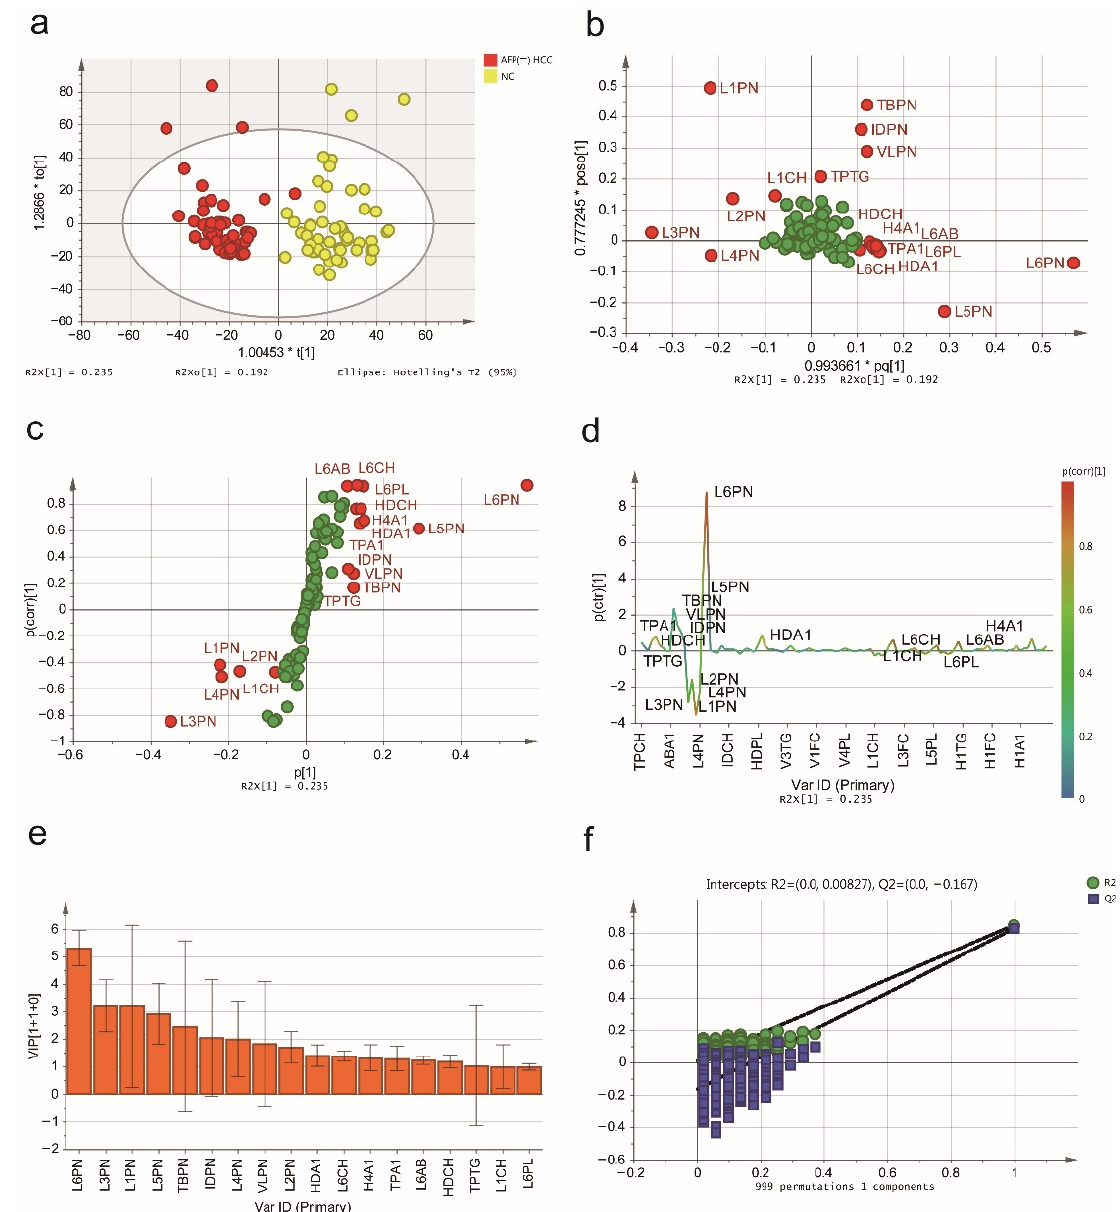
Figure 3. The serum lipidomic profile discriminates between AFP-negative HCC patients and NCs. ( a ) Score plot was generated by the OPLS-DA model. The horizontal coordinate (1.00453 * t [1]) represents the score value of the main component, and the vertical coordinate (1.2866 * to [1]) represents the score value of the orthogonal component. ( b ) Loading plot was generated by the OPLS-DA model. The horizontal coordinate (0.993661 * pq [1]) represents the predicted principal component, and the vertical coordinate (0.777245 * poso [1]) represents the orthogonal principal components. The corresponding ( c ) S-plot and ( d ) S-line plot for the model displaying the discriminant variables and the associated predictive loadings. The red circles indicate selected lipoprotein subfractions with VIP scores >1.0, and other variables with no difference are referred to as green circles in ( b , c ). ( e ) The selected lipoprotein subfractions with VIP scores >1.0. ( f ) Permutation test (999 times) of the OPLS-DA model.